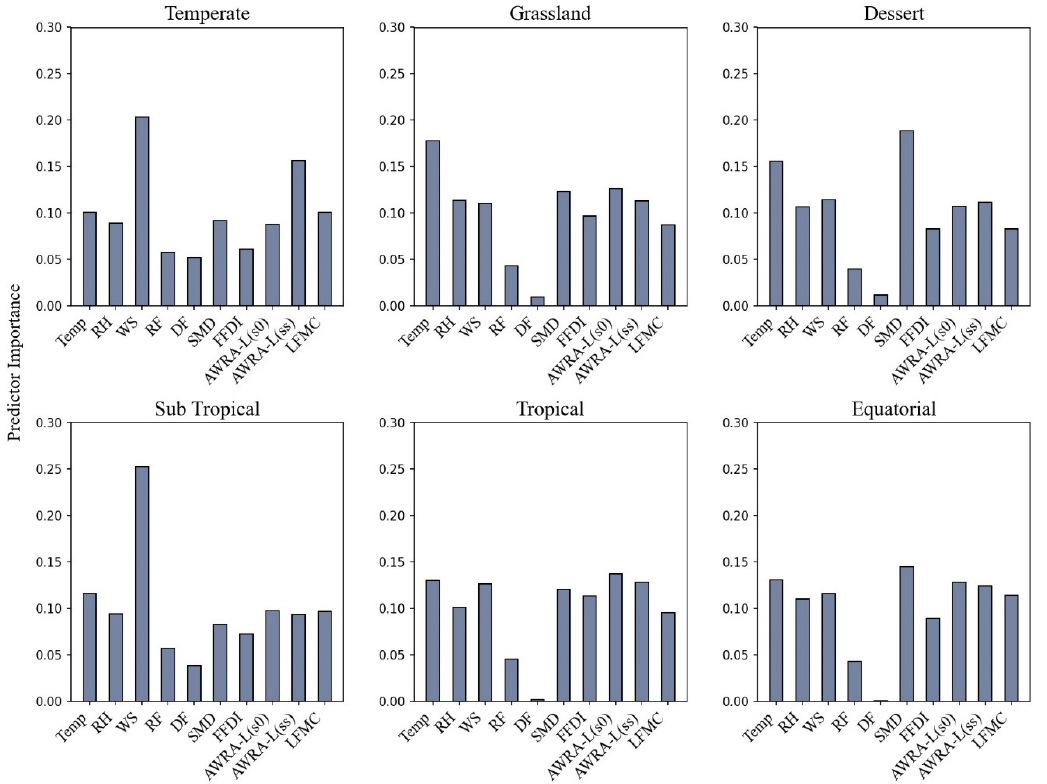
Figure 4. Predictor importance for predicting fire sizes, computed with feature (predictor) importance property of RF for all climate zones. T: Temperature, RH: Relative humidity, WS: Wind speed, DF: Drought factor, SMD: Soil moisture deficit, FFDI: Forest fire danger index, LFMC: Live fuel moisture content.